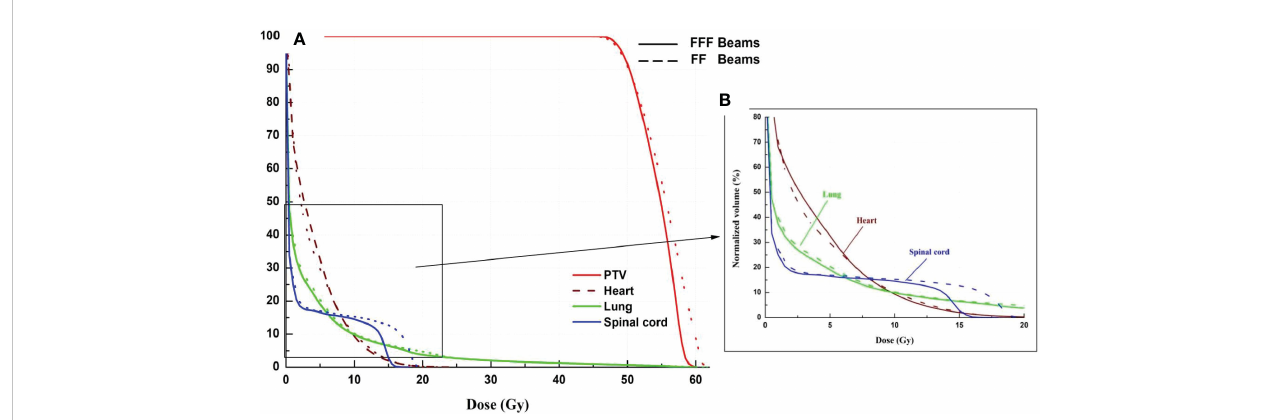
FIGURE 3 Dose-volume histogram of target and selected OARs. (Solid line: VMAT FFF , Dashed line: VMAT FF ). (A) dose ranges from 0 to 61 Gy. (B) dose ranges from 0 to 20 Gy.